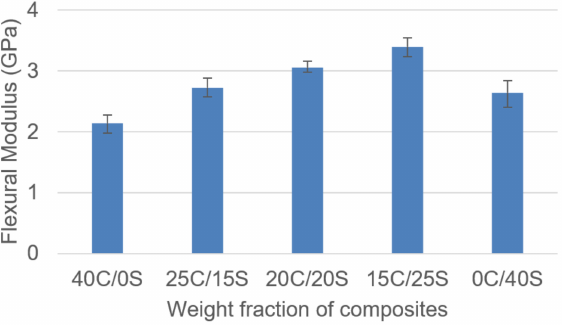
Figure 8. Flexural modulus vs. weight fraction of C/S